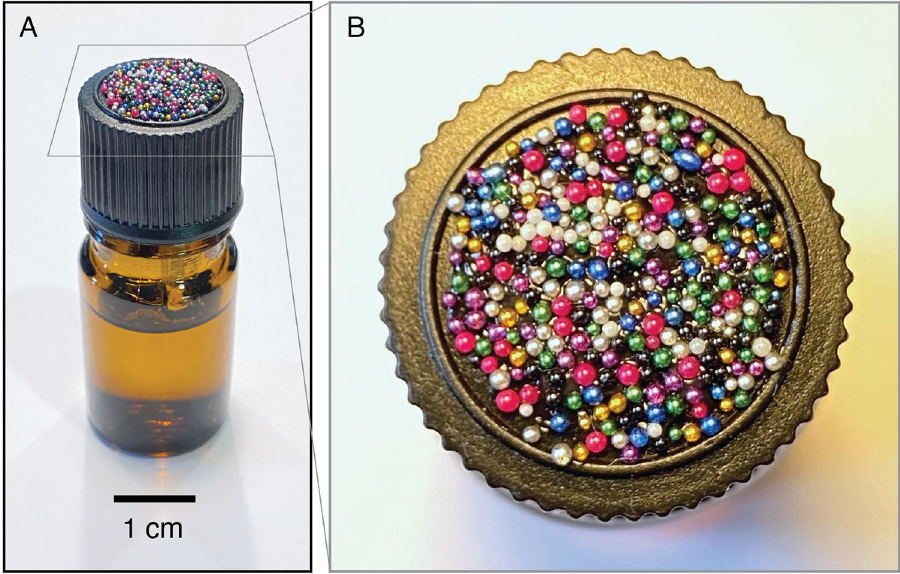
Figure 8. By applying adhesive to the cap of a small bottle and then pressing the cap into a bed of multicolored plastic spheres, the bottle receives a universally unique CandyCode that can subsequently be photographed and used to verify the authenticity of the bottle’s contents (assuming that the seal is intact). This CandyCode is only about a centimeter in size but contains nearly 300 easily-distinguishable microbeads; this is almost three times the number of nonpareils per CandyCode used in this work, meaning that this bottle’s CandyCode is universally unique and will never be duplicated by random